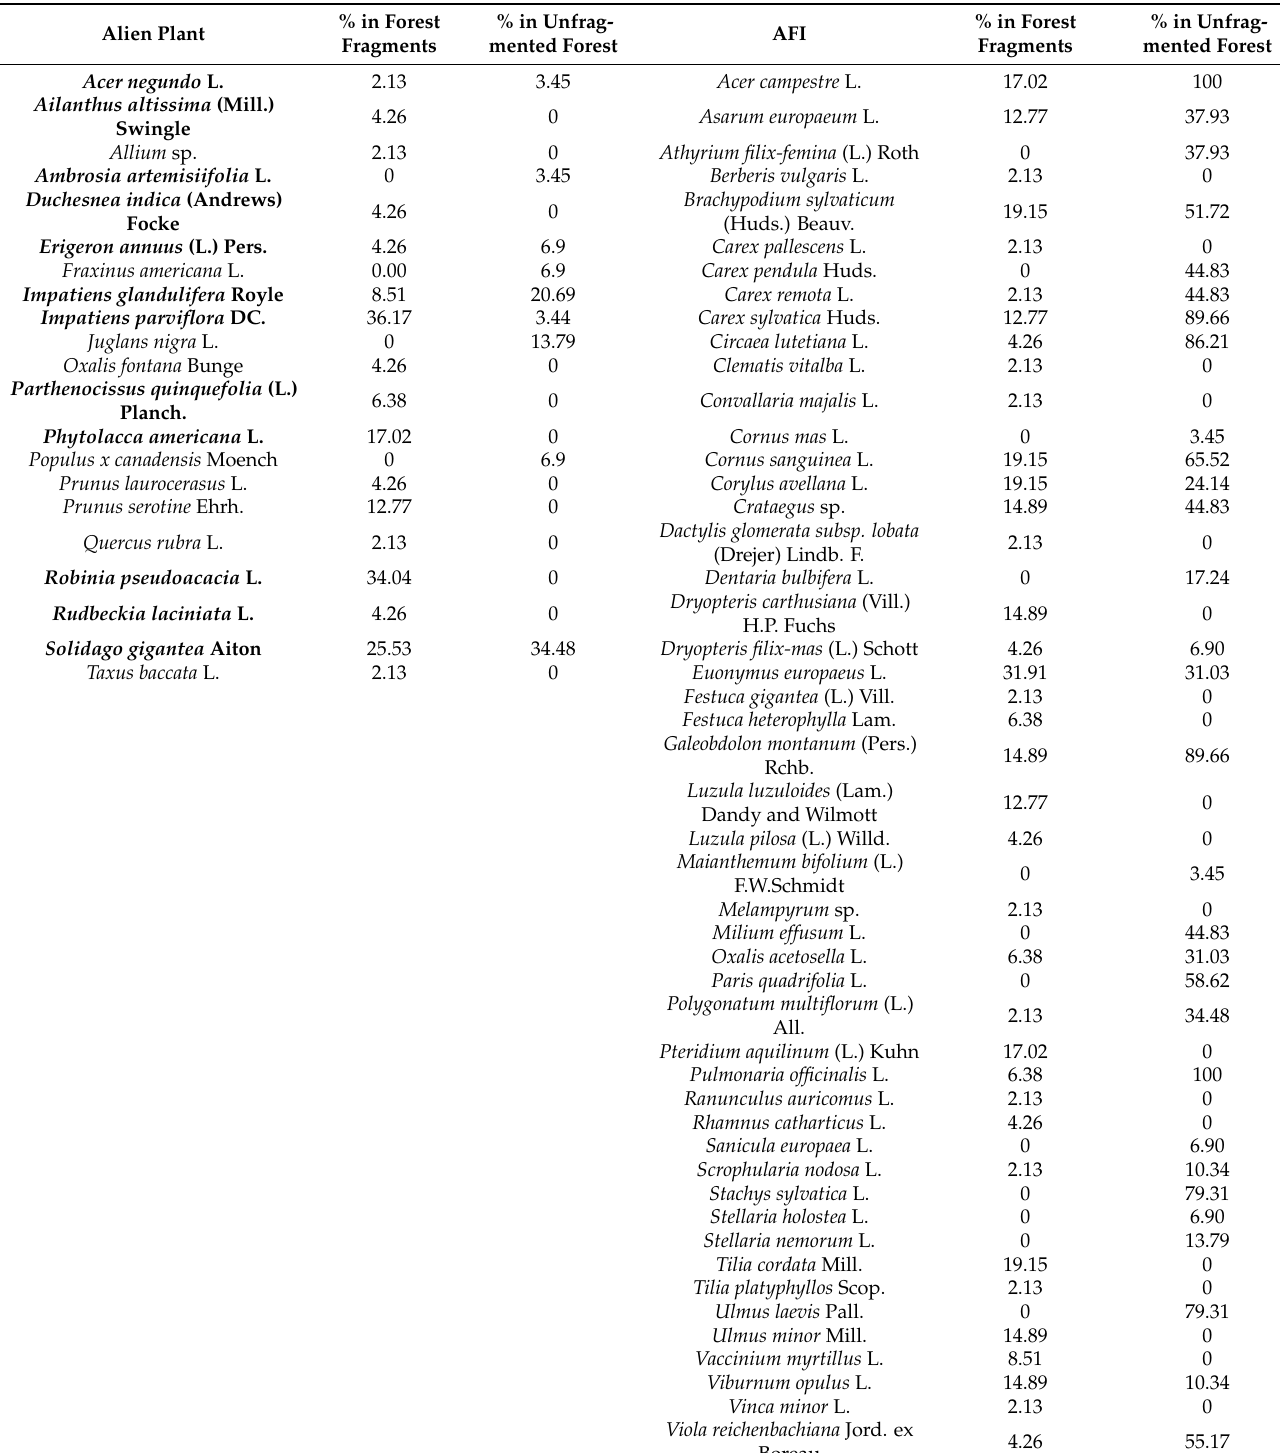
Table 1. List of alien plant species and ancient forest indicator plants (AFI) present in forest fragments of Apaško polje and Dravsko polje (N = 47) and unfragmented forest Murska šuma (N = 29). Invasive alien plants (according to Jogan et al. [28], P. americana was later recognized as invasive) are in bold. % in Forest % in Unfrag- Fragments mented